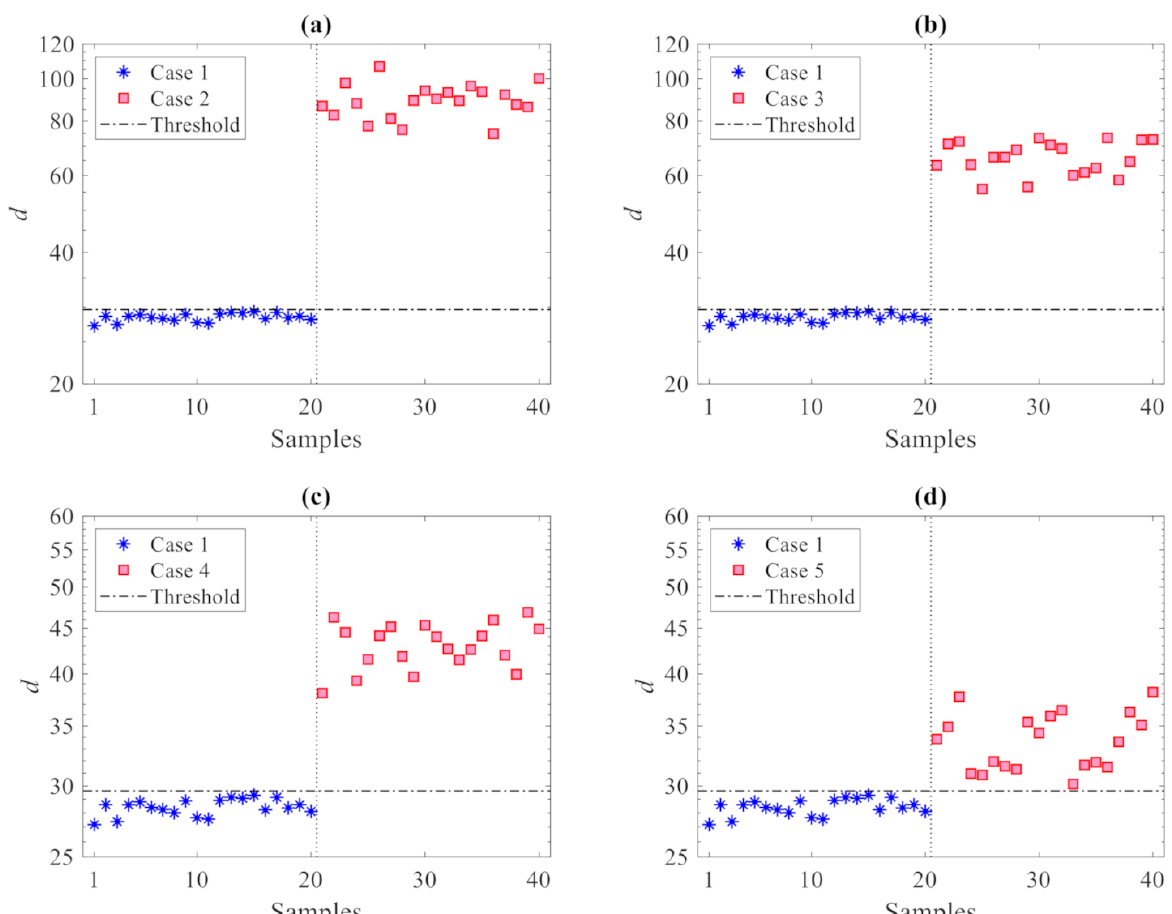
Figure 4. ASCE problem: damage detection via the proposed CMDS method using p = 20 partitions: damage ( a ) Case 2, ( b ) Case 3, ( c ) Case 4, and ( d ) Case